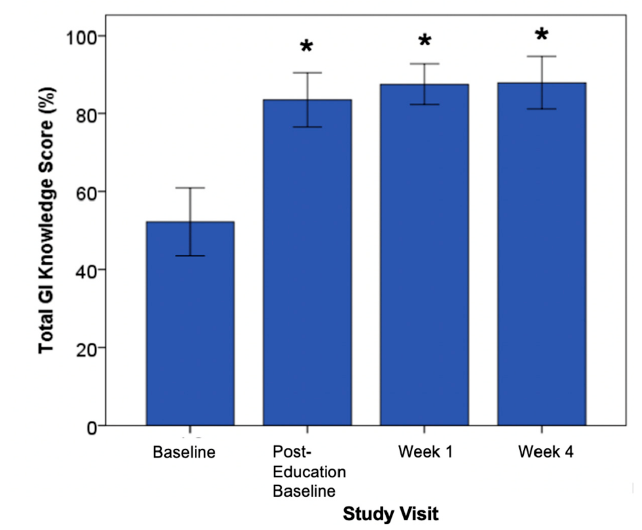
Figure 2. Glycemic index knowledge score at each study visit (Glycemic Index Questionnaire (GIQ) Section 3). * Significantly different from baseline score; mean (± SEM); p < 0.05.